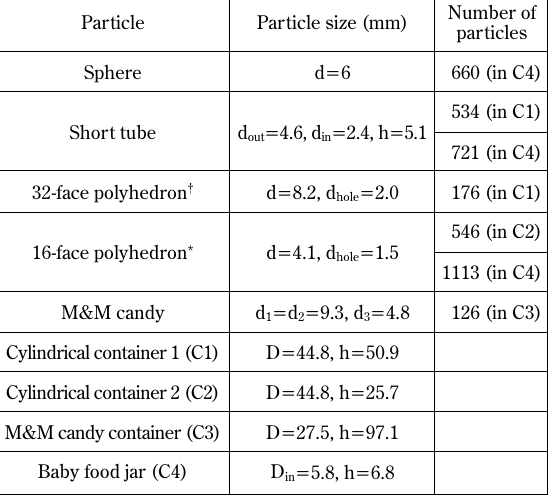
Table 1 Geometric parameters of objects and containers and num- ber of particles used